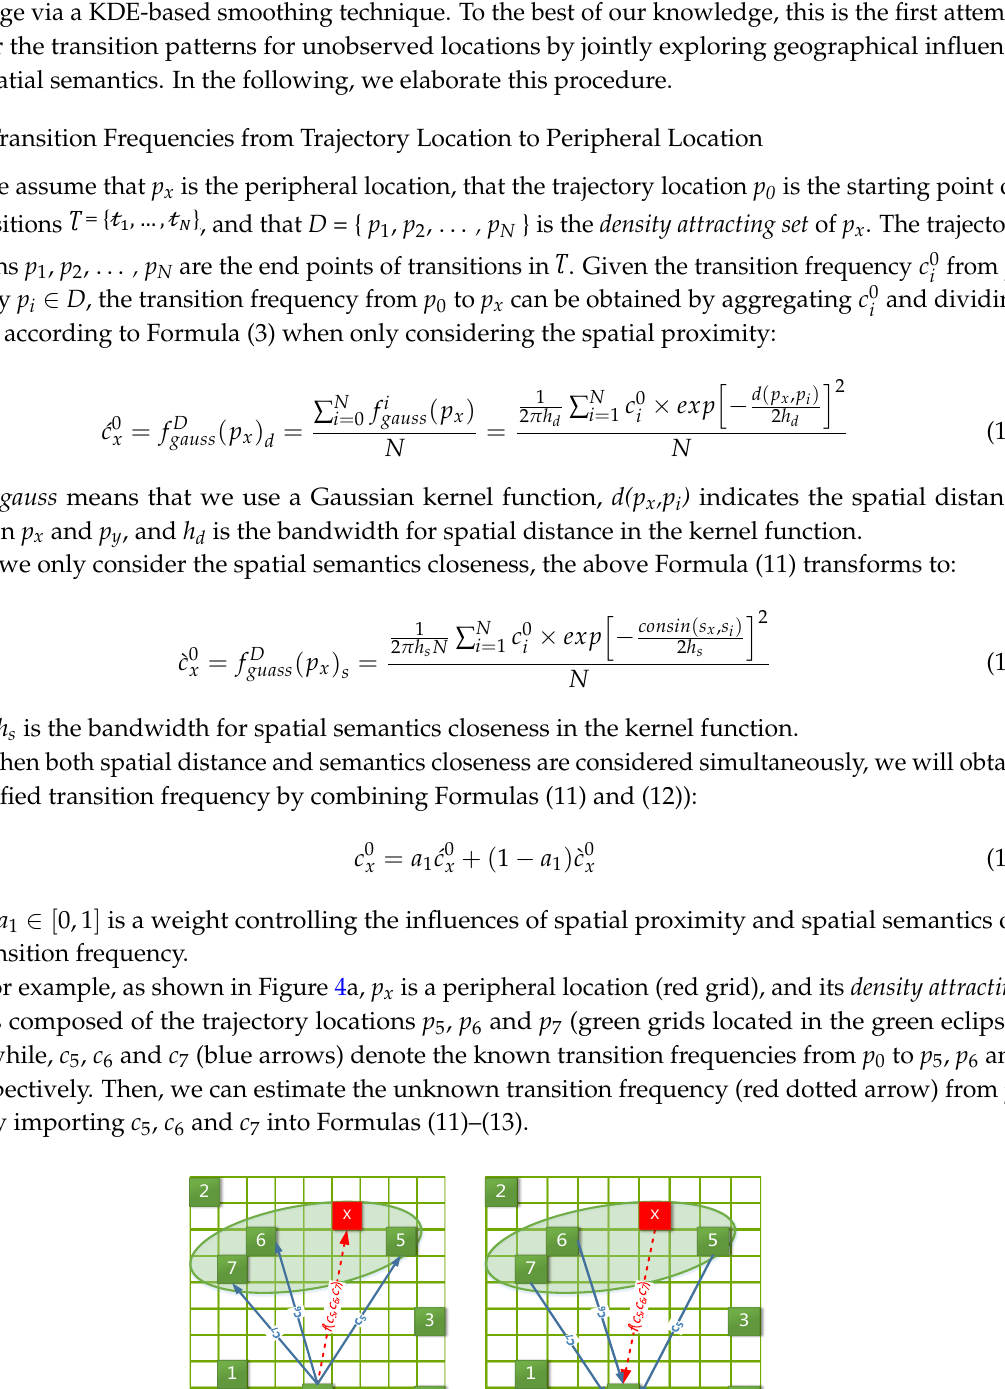
( b ) Figure 3. ( a ) No transition information for unobserved location ( b ) Transition information for unobserved location. Therefore, to improve the generalization capability of the prediction model, this section will estimate the transition frequencies in three instances as shown in Figure 3b: (1) transition frequencies